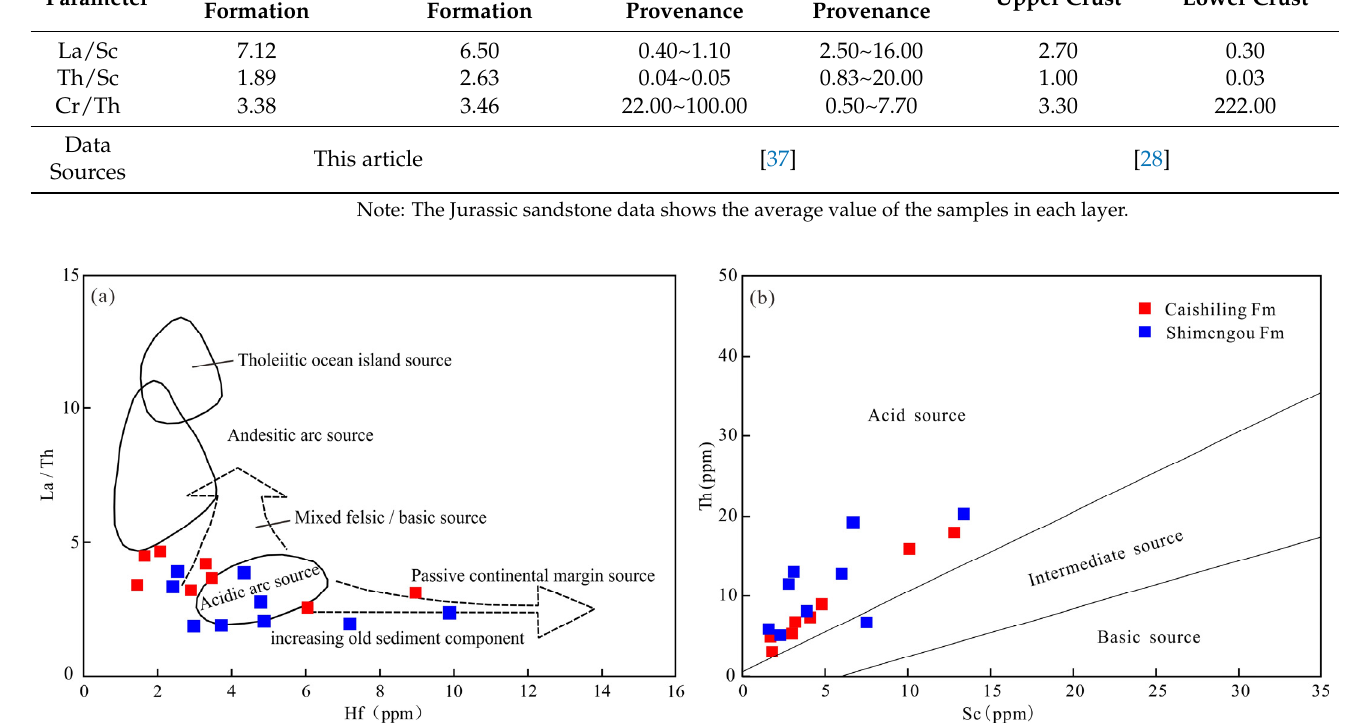
Table 5. Ratio-discriminant table of trace elements of Jurassic sandstones in the Yuqia uranium ore fields.